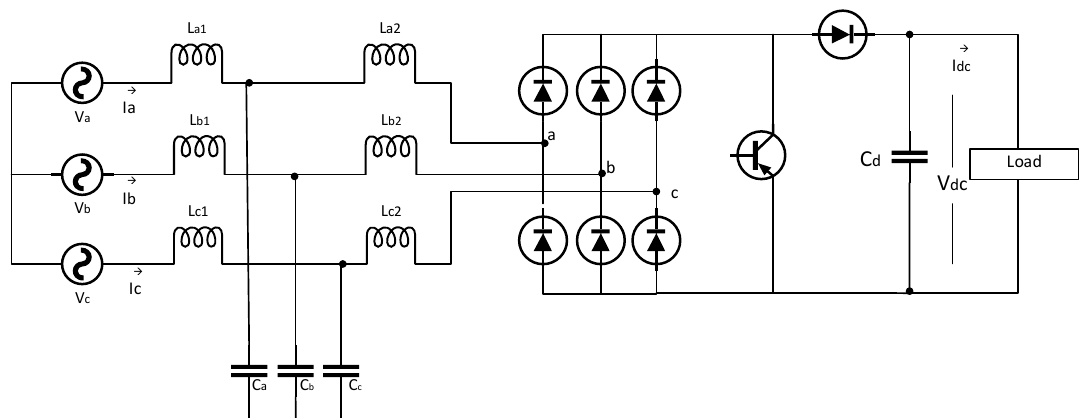
Figure 8. Unidirectional boost converter charger for BSS. (Adapted from [16]).